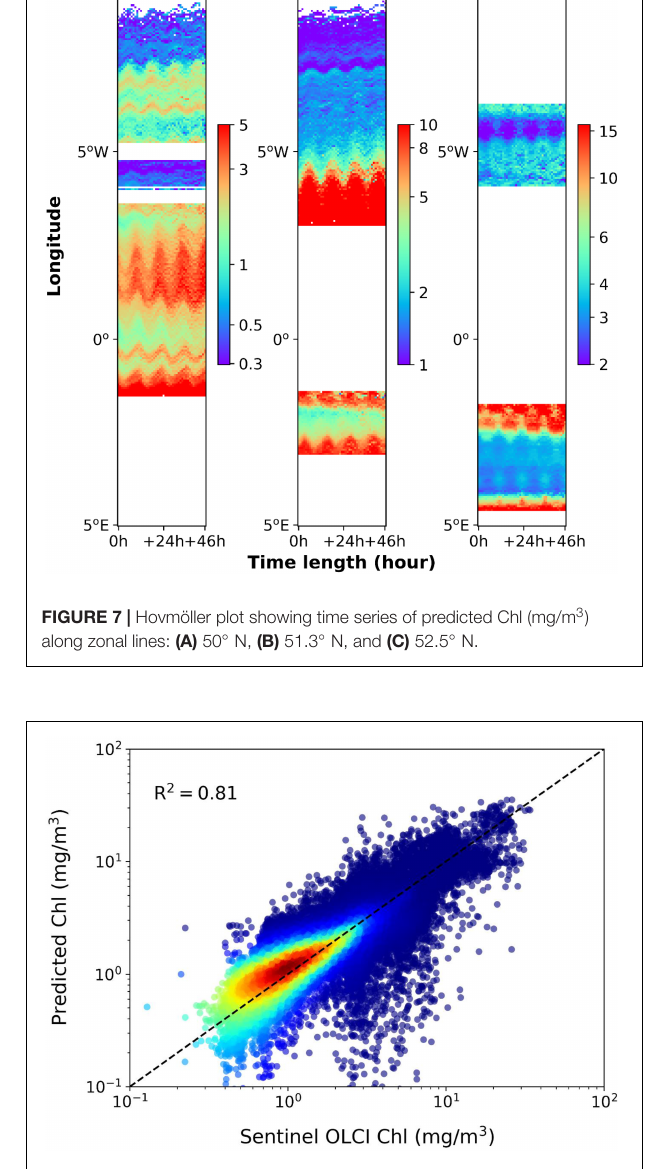
FIGURE 8 | Comparison of Sentinel OLCI Chl with predicted Chl on September 17, 2019 (MAPE = 36.9%); the linear regression between the two datasets is y = 0.79 x + 0.28 ( r 2 =